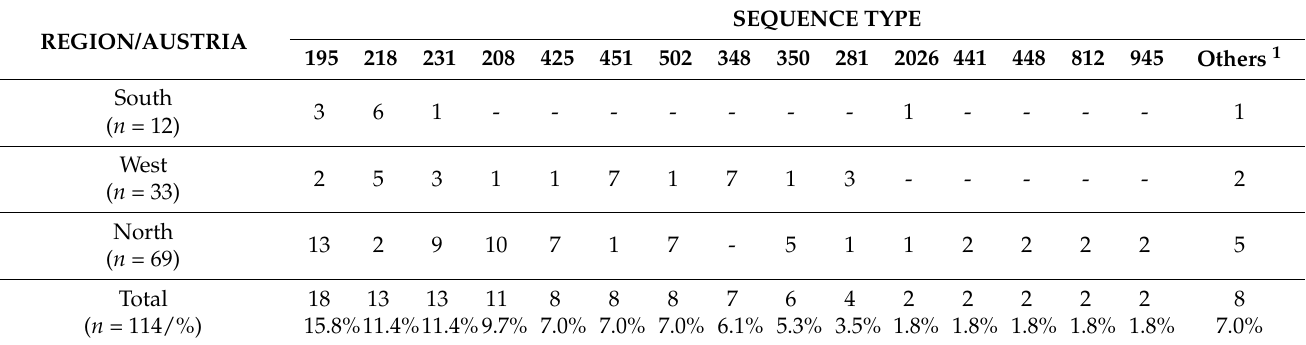
harbored bla OXA-58-like only. Only two ST218 isolates were found in Vienna, both in 2016,